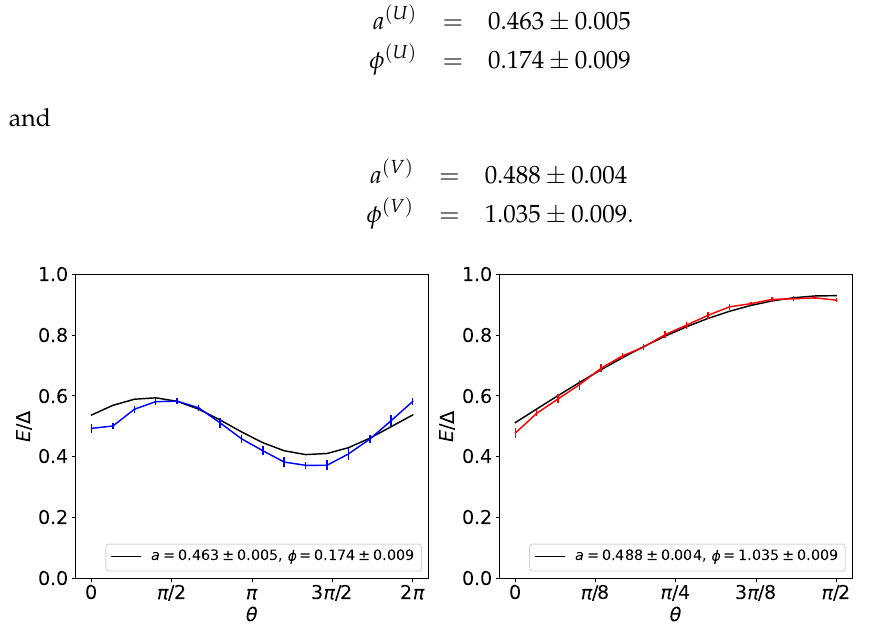
Figure 4. (Color online). Best fit of the energy stored into the QB (in units of ∆ ) as a function of θ (black curves). Data correspond to Gaussian pulses applied after the action of a unitary matrix U (blue curve in the left panel) or V (red curve in the right panels) over the ground state of the system. These transformations are defined in Equations (39) and (40) of the main text, respectively. Every point is obtained averaging over 10 different measurements, and the bars take into account the standard error associated to this average. In both cases, the measurement time has been fixed at t m = 600